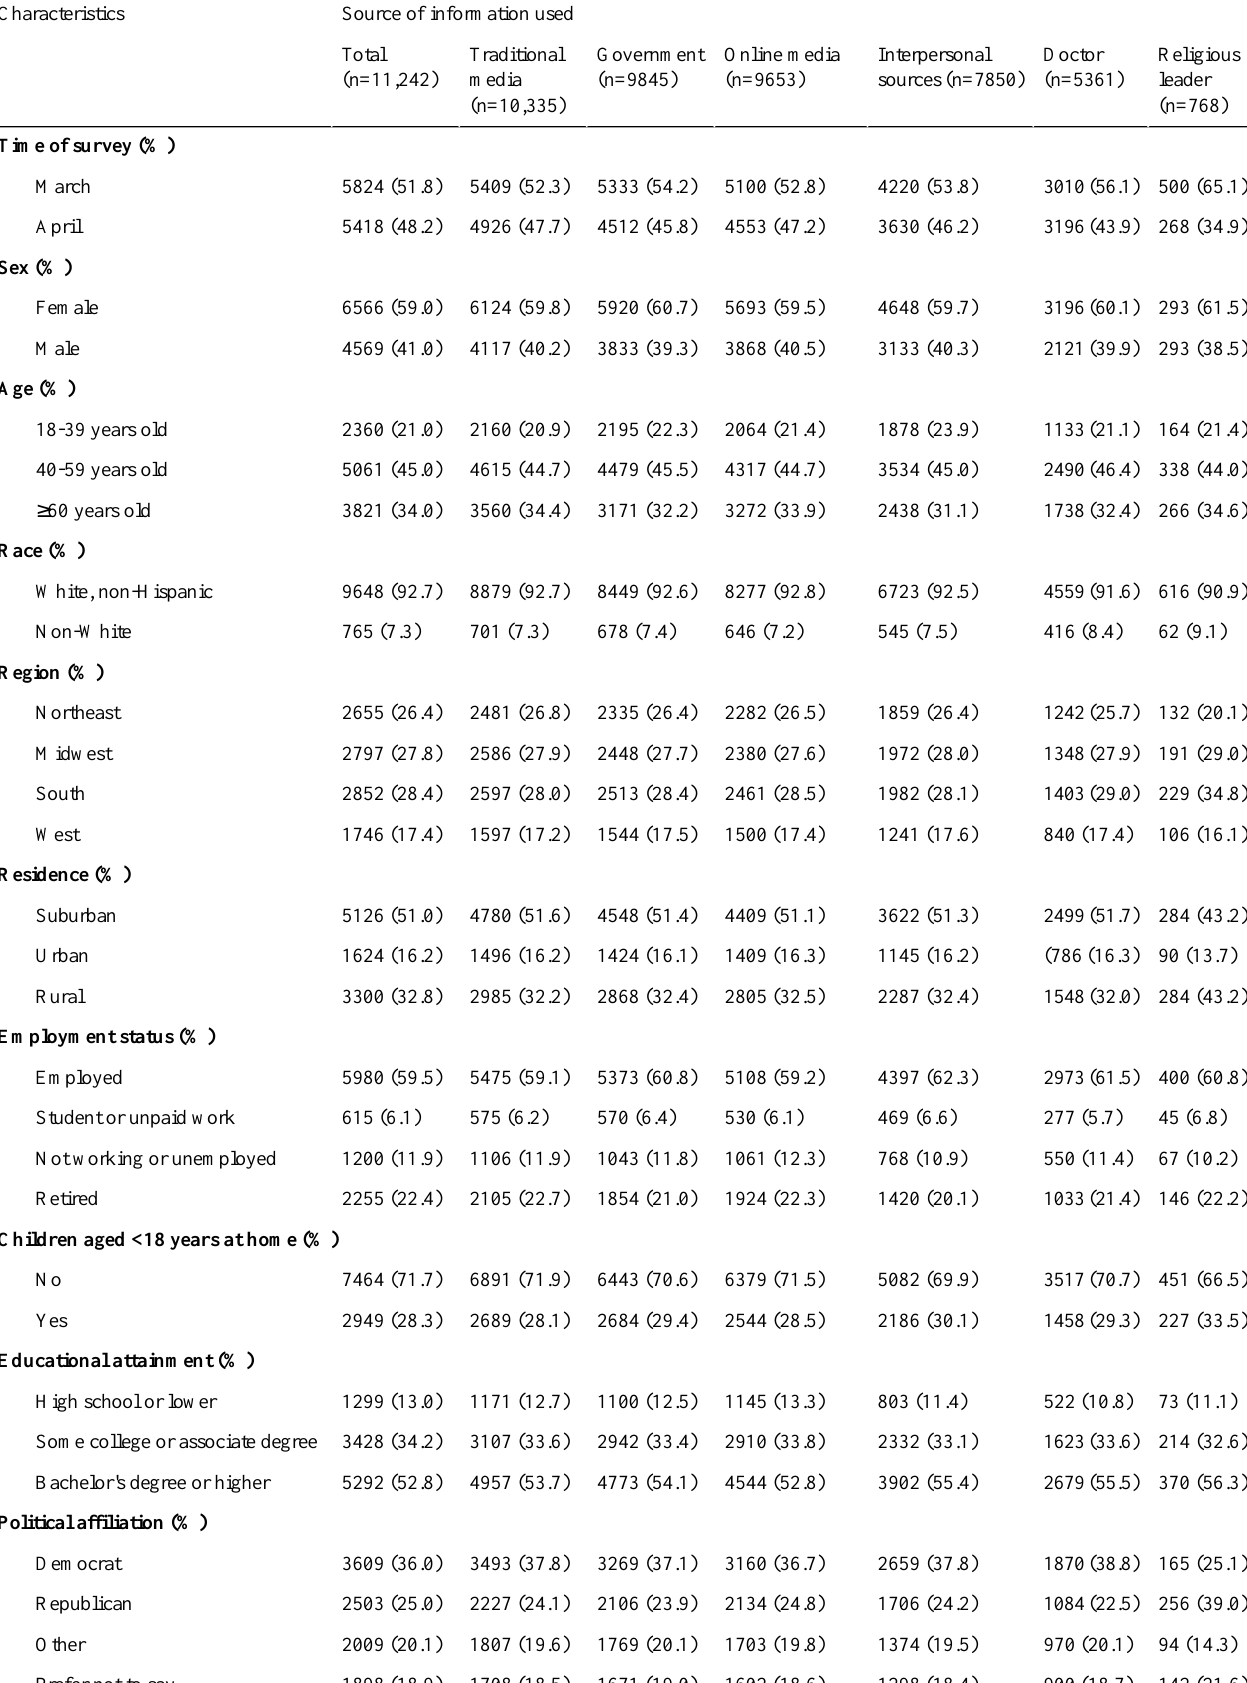
Table 1. Characteristics of 11,242 participants with data on COVID-19 sources of information in online survey, March-April 2020 a . Source of information